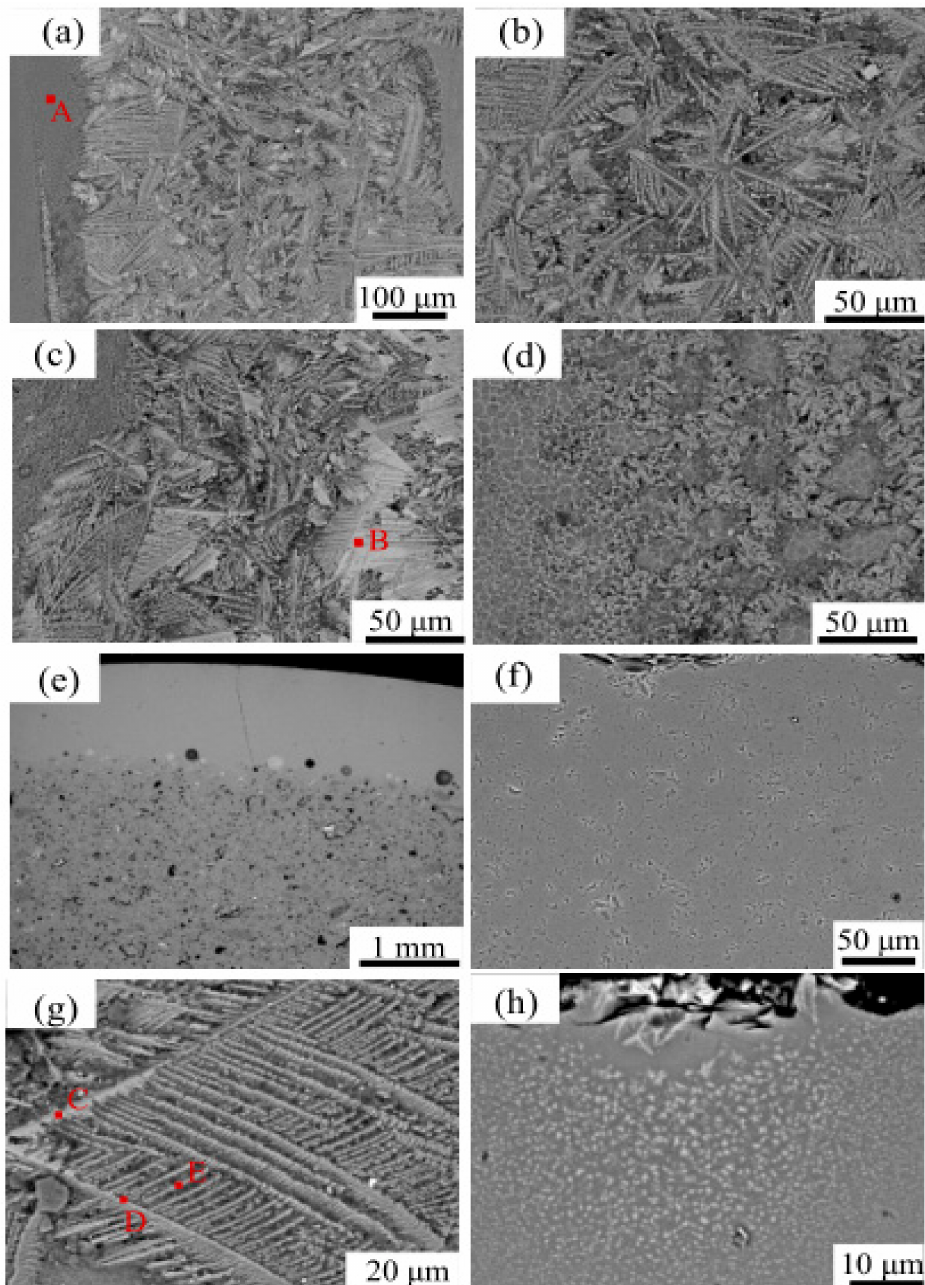
Figure 6. SEM images of the HF glaze with different magnifications: ( a – d , g ) surface morphology; ( e , f , h ) the polished cross-section morphology. (Point A: black glazed area; Point B: crystalline area; Point C: large-scale main branches; Point D: secondary branches; Point E: tertiary